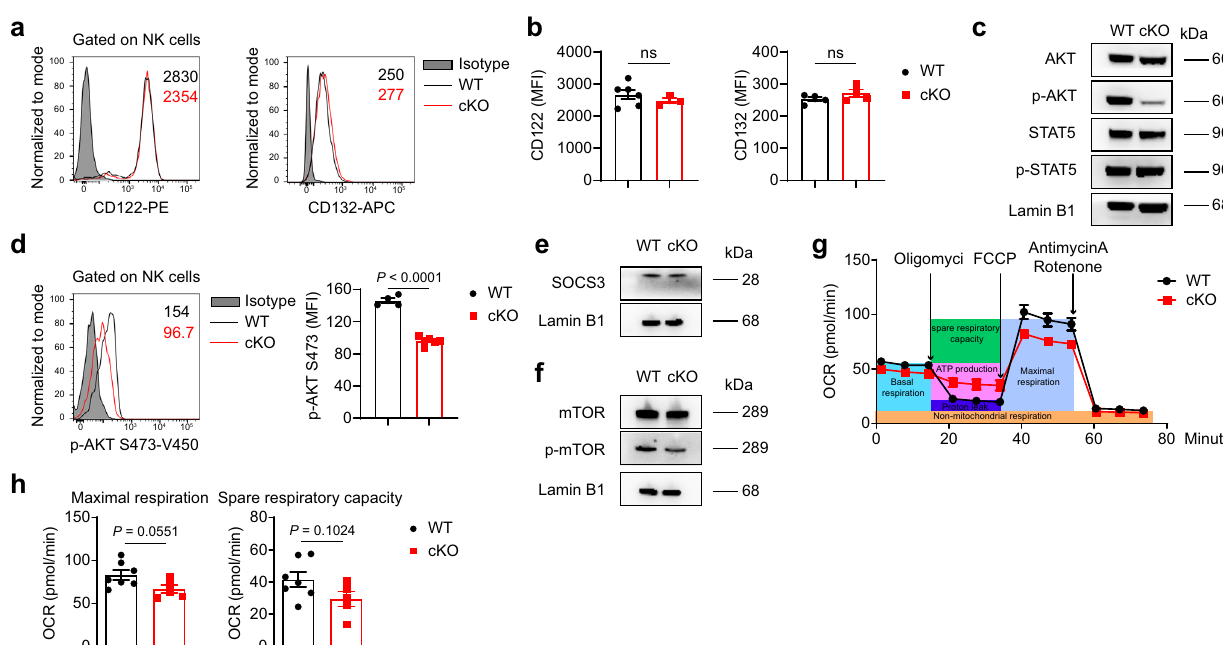
Fig. 6 The IL-15-AKT pathway is impaired in METTL3-de fi cient NK cells. a , b Representative histograms ( a ) and MFI ( b ) of CD122 and CD132 expression in splenic NK cells from WT ( n = 6 for CD122, n = 4 for CD132) and cKO ( n = 3 for CD122, n = 4 for CD132) mice. c , e , f Immunoblotting of indicated molecules in splenic NK cells upon stimulation with rmIL-15 (50 ng/mL) for 1 h. The NK cells were sorted from WT and cKO mice that received hydrodynamic injection of the pLIVE-IL-15 plasmid or pLIVE control plasmid 1 – 2 months previously. d Representative histogram (left) and MFI (right) of p-AKT (S473) expression in splenic NK cells upon stimulation with rmIL-15 (50 ng/mL) for 1 h ( n = 4 for WT group; n = 6 for cKO group). g , h Splenic NK cells from WT or cKO mice were cultured with rmIL-15 overnight (10 ng/mL), and then the indicated compounds were added into each well at the indicated times. g The oxygen consumption rate was measured for NK cells. h Statistical graphs showing the maximal respiration and spare respiratory capacity of NK cells ( n = 7 for WT group; n = 5 for cKO group). Each symbol represents an individual mouse ( b , d ) or an individual well of a cell culture plate ( h ). Data are the mean ± SEM (ns, not signi fi cant; unpaired two-tailed t test ( b , d , h )). Source data are provided as a Source Data fi le. Data represent at least two independent experiments ( a – h